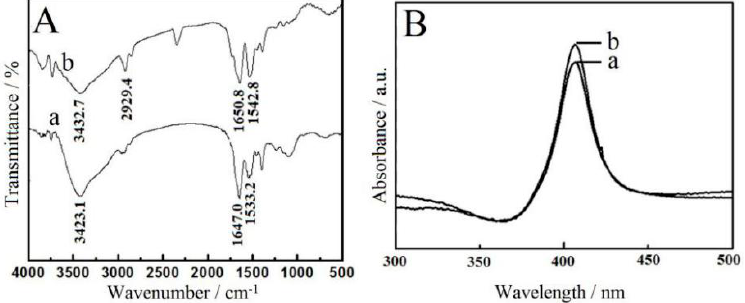
Figure 2. ( A ) FT-IR spectra of Hb ( a ) and CMS-Hb ( b ); ( B ) UV-Vis spectra of Hb ( a ) and CMS-Hb ( b ).